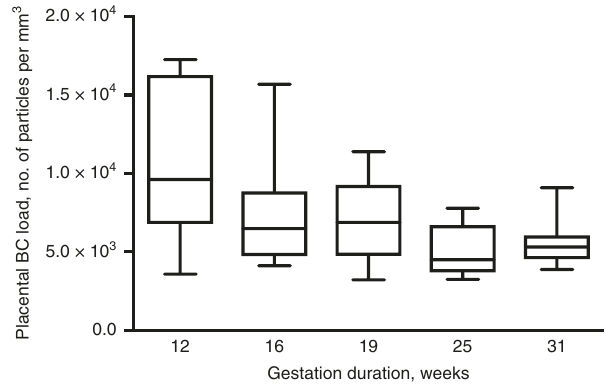
Fig. 5 BC load in placentae from spontaneous preterm births ( n = 5). The whiskers indicate the minimum and maximum value and the box of the box plot illustrates the upper and lower quartile. The median of spreading is marked by a horizontal line within the box. Source data are provided as